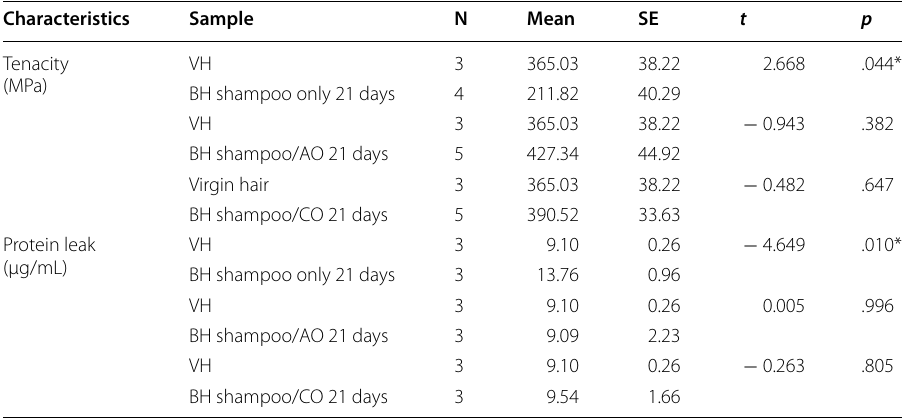
Table 20 Comparison of physical characteristics between virgin hair (VH) and bleached hair (BH) shampooed with or without the use of Argan oil (AO) or Camellia oil (CO) conditioner